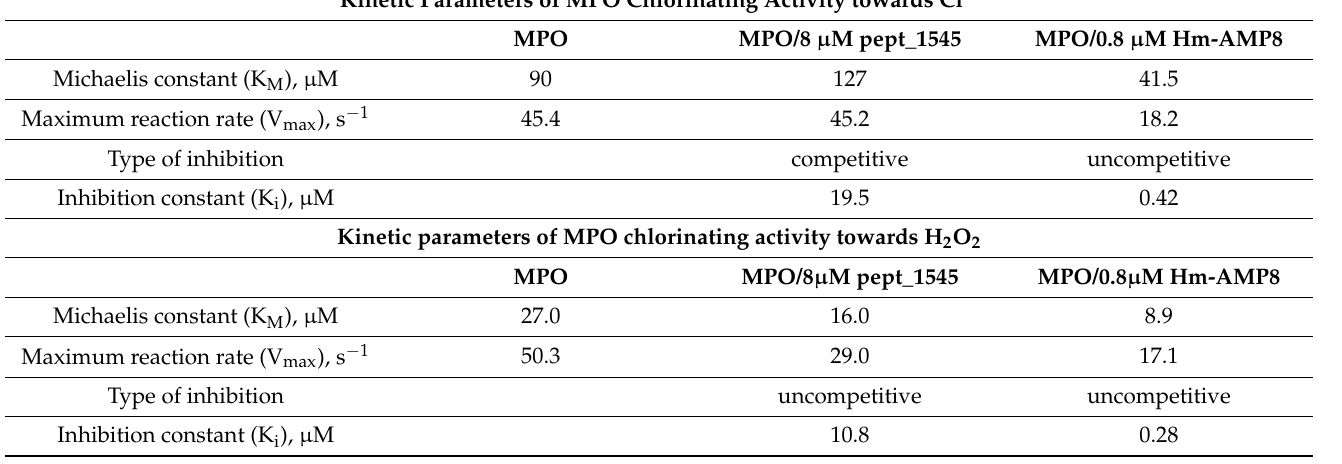
Table 4. Pept_1545 and Hm-AMP8 inhibit MPO. Kinetic parameters for MPO chlorinating activity towards chloride anion Cl − (upper panel) and H 2 O 2 (lower panel), as measured by CB oxidation by MPO (0.8 nM MPO) in the absence and presence of the peptides in 50 mM Na-acetate buffer, pH 5.5. The data presented were obtained using the Hanes–Woolf linearizations for different NaCl concentrations with 50 µ M H 2 O 2 and for different H 2 O 2 concentrations with 150 mM NaCl.